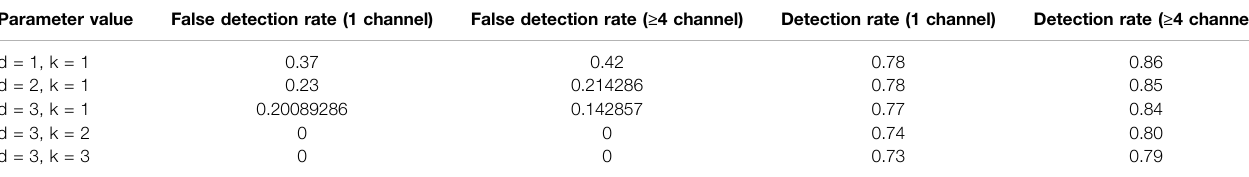
TABLE 1 | Effect of the threshold on seizure detection. Parameter value False detection rate (1